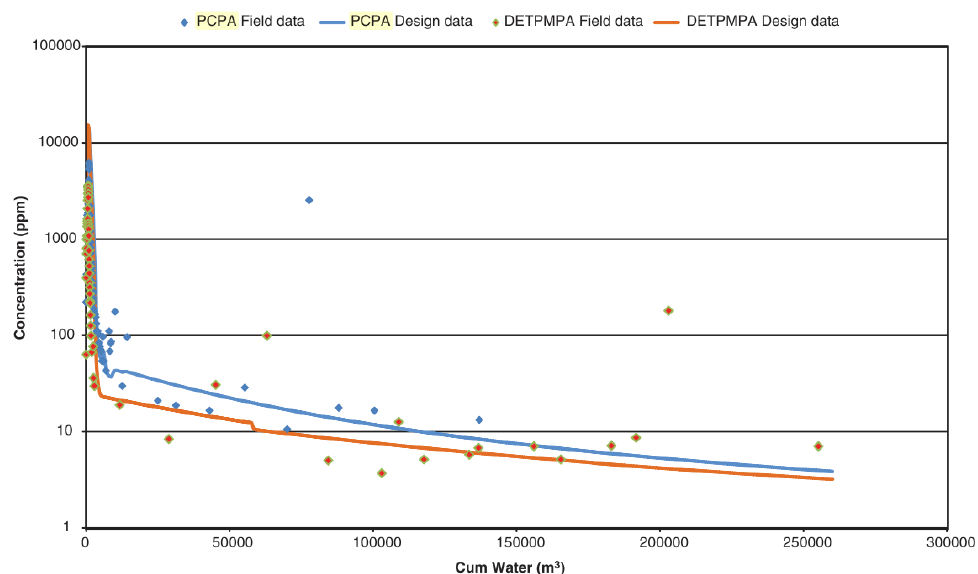
Figure 16. Field returns of incumbent inhibitor Product B and the subsequent field trial with Product Figure 15. Comparison of inhibitor return profiles at different field treatments [ Error! Reference source not found. ]. A on Well E-22 [41].